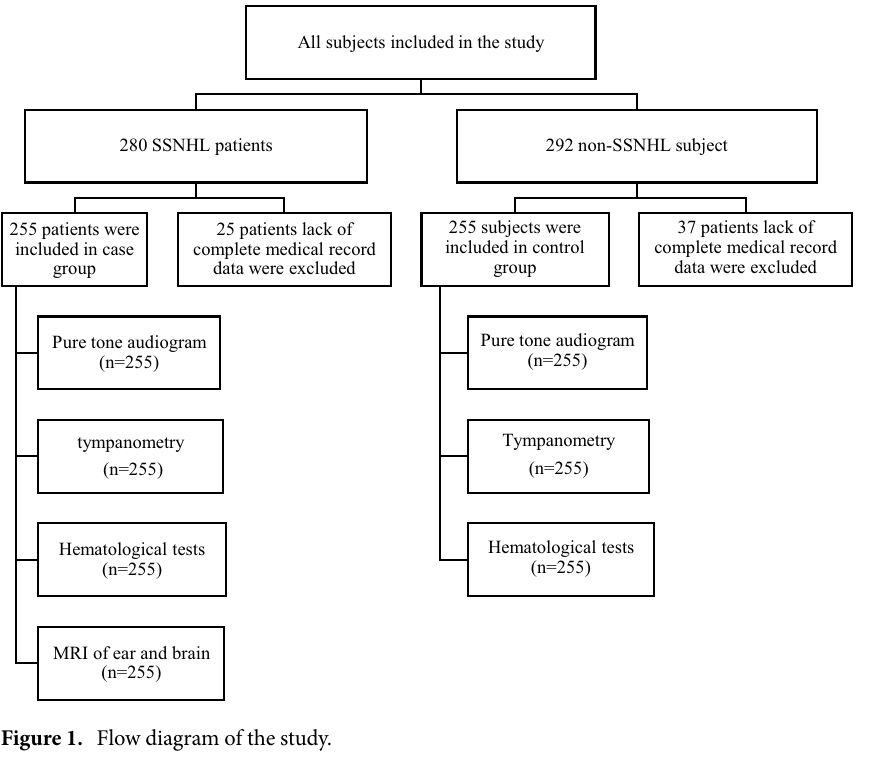
Figure 1. Flow diagram of the study.